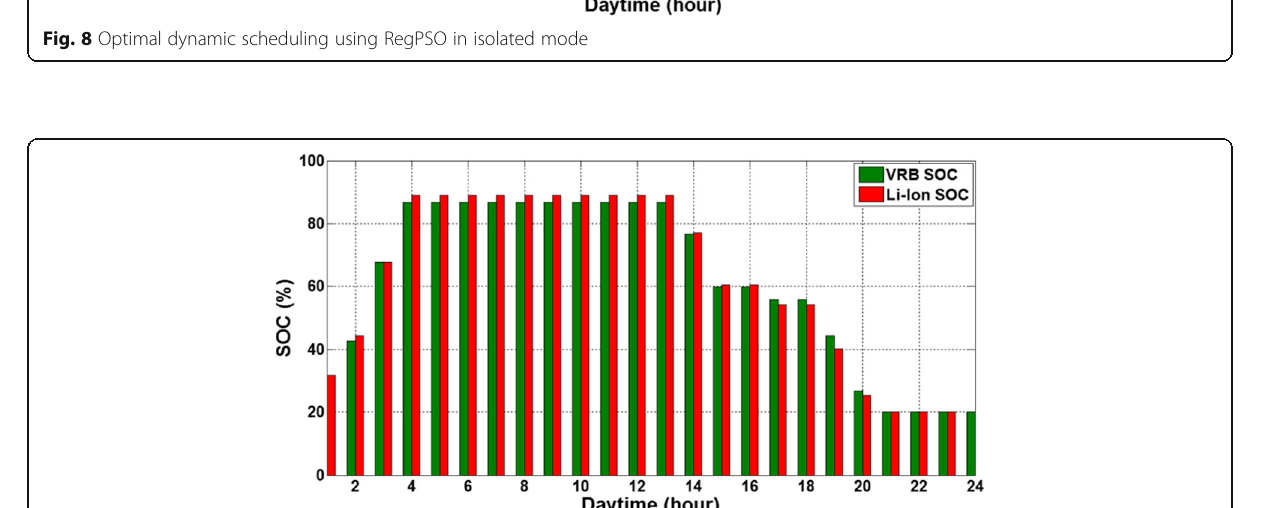
Fig. 9 SOCs of VRB and Li-Ion battery obtained using RegPSO in isolated